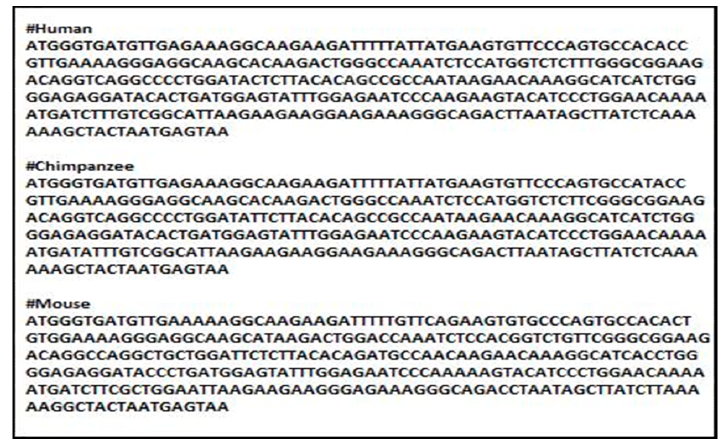
Figure 2. Samples represent DNA sequences for Cytochrome C in human, chimpanzee and mouse.